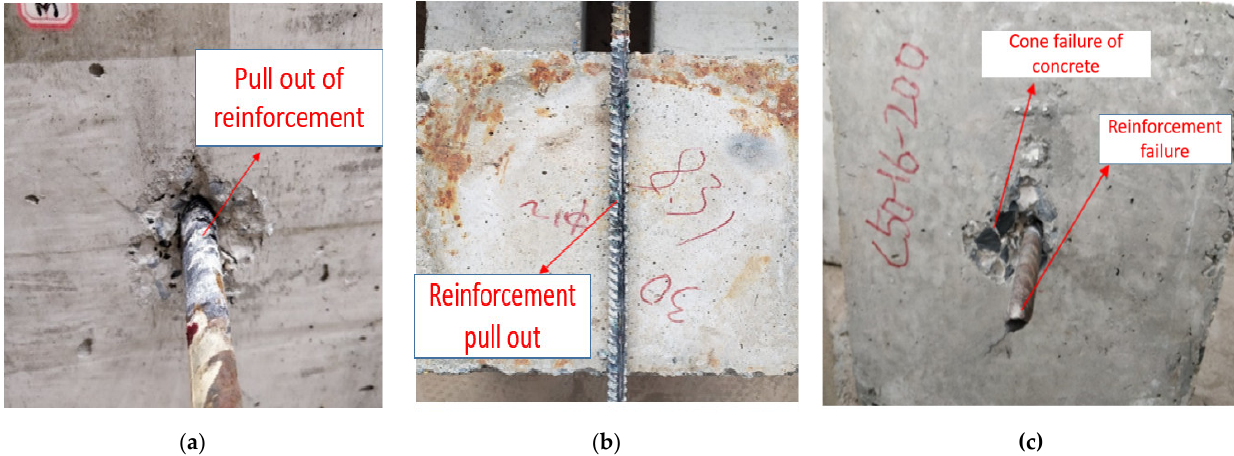
Figure 4. ( a ) Pull-out failure of reinforcement at loading end. ( b ) Cone-shaped failure after pulling out. ( c ) Tensile failure of reinforcement.